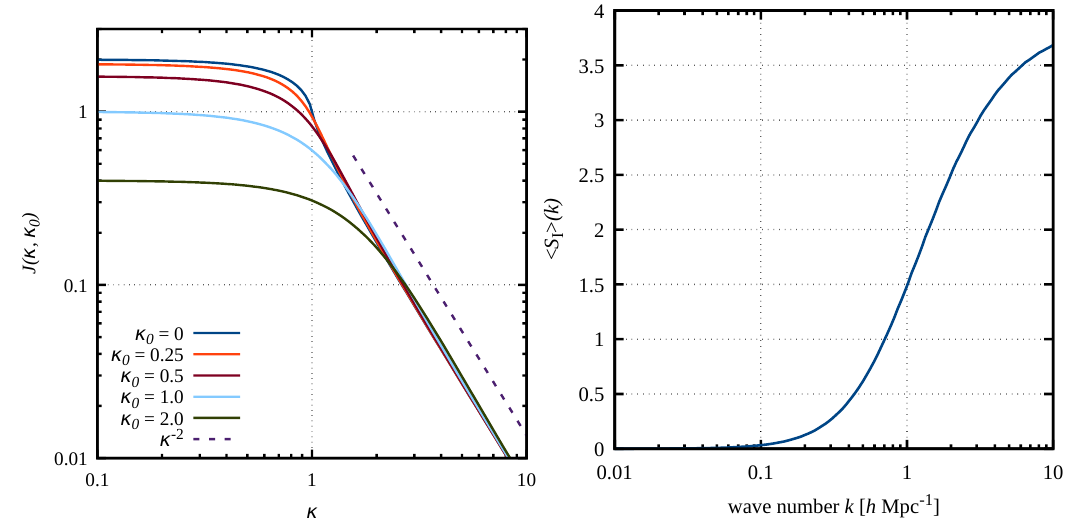
〉 12 ) ∝ κ − 2 0 ) for κ (cid:28) 1. 0